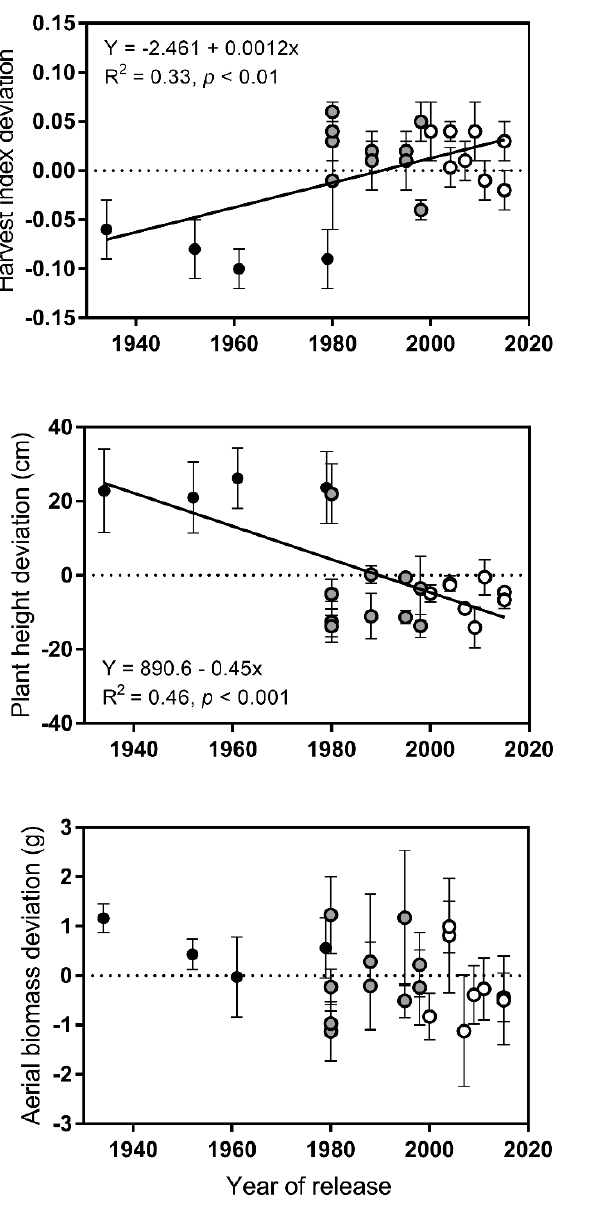
Figure 3. Regression analyses between harvest index, plant height, aerial biomass, grain protein content and heading date deviations and the cultivar’s release year. Each point represents the average of trait deviation for each cultivar with respect to the mean value in each experiment (Cabildo and Pieres in 2014 and Barrow in 2017). Black, grey and white points correspond to the cultivars released in the periods 1934–1979, 1980–1999 and 2000–2015, respectively. Horizontal dotted lines represent the mean value of the trait for each experiment, and the vertical lines for each point represent the standard error of the mean.